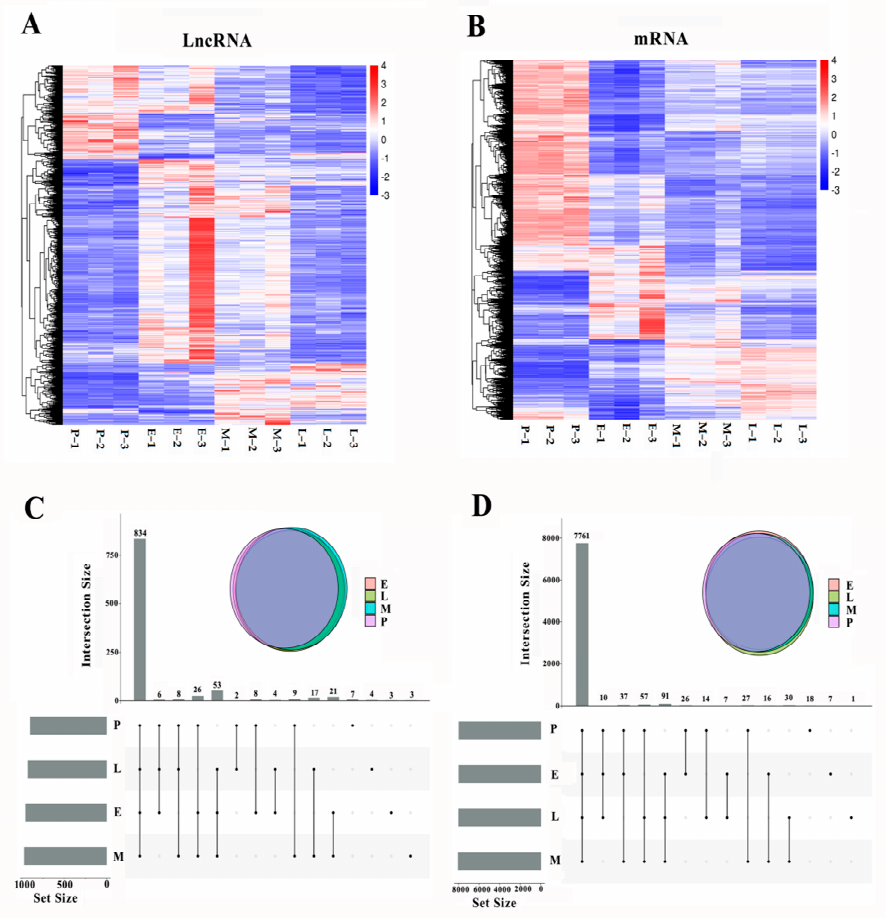
Figure 2. Differential expressed (DE) lncRNA and mRNA. ( A ). The clustered Heatmap of the global expression changes of DE lncRNAs. Red indicates high expression levels, and blue represents low expression levels. ( B ). The clustered Heatmap of the global expression changes of DE mRNAs. ( C ). The Upset Venn of total amount of the unique lncRNAs in different stages of the cells. ( D ). The Upset Venn of total amount of the unique mRNAs in different stages of the cells.